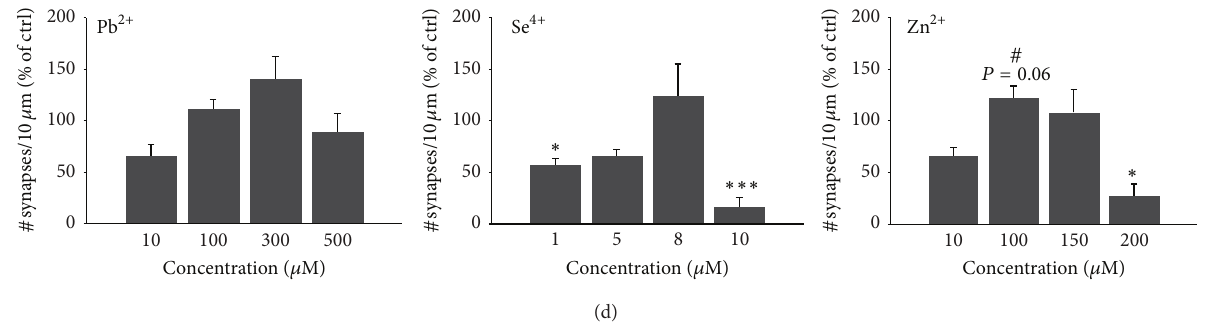
Figure 1: Toxicity profiles of trace elements in primary hippocampal neuronal cell culture. ((a), (b)) The amount of cell death was calculated using various concentrations for each trace metal by assessing the number of neuronal apoptotic nuclei (identified by MAP2 and DAPI staining) per optic field (from 5 fields of view and 𝑛 = 3 cultures) normalized against the total number of neurons per optic field. The results show no changes in cell health over a wide spectrum of concentrations for Al, Fe, and Pb, and a linear correlation between metal level and cell death for Cd, Cu, and Zn. A linear correlation might also exist for Hg and Se although an exponential increase in cell death beyond a certain concentration is more likely. Addition of Mg increased cell survival in a low concentration range and with higher concentrations leading to cell death (a). (b) Using 𝑡 -tests, 𝑃 values were calculated to evaluate, whether changes between different concentrations compared to untreated control cells are significant. (c) As an alternative read-out, the number of primary, secondary, and tertiary dendrites was investigated. Cells were stained with MAP2 antibody. As signs of cell death, neurons show fragmentation (pinching off) dendrites, starting with branches more distal from the soma. Dendrites showing signs of fragmentation were not counted. High concentrations of metals that were shown to lead to cell death ((a), (b)) lead to a reduction in dendritic branching starting from tertiary dendrites and also affecting secondary and primary in the most toxic cases. Although, for some metal, no significant cell death in a certain concentration was seen, and already a fragmentation of dendrites is visible (e.g., 5 𝜇 MHg). Mg and Zn show a significant increase in dendritic branching restricted to tertiary dendrites in a lower concentration range. (d) To assess whether some trace elements display a synaptogenic effect, synapses were labeled using Bassoon fluorescence and the number of Bassoon positive puncta was measured per 10 𝜇 m dendrite length on primary dendrites (3 dendrites per cell, 10 cells in total per metal and concentration). While synapse number is decreased correlating with toxic effects for most metal ions, such as Cd, Cu, and Se, an increase in synapse number can be seen for Fe and lower concentrations of Mg and Zn (seen as a trend). ((a)–(d)) All cells were treated with metals between DIV 10 and DIV 14 before